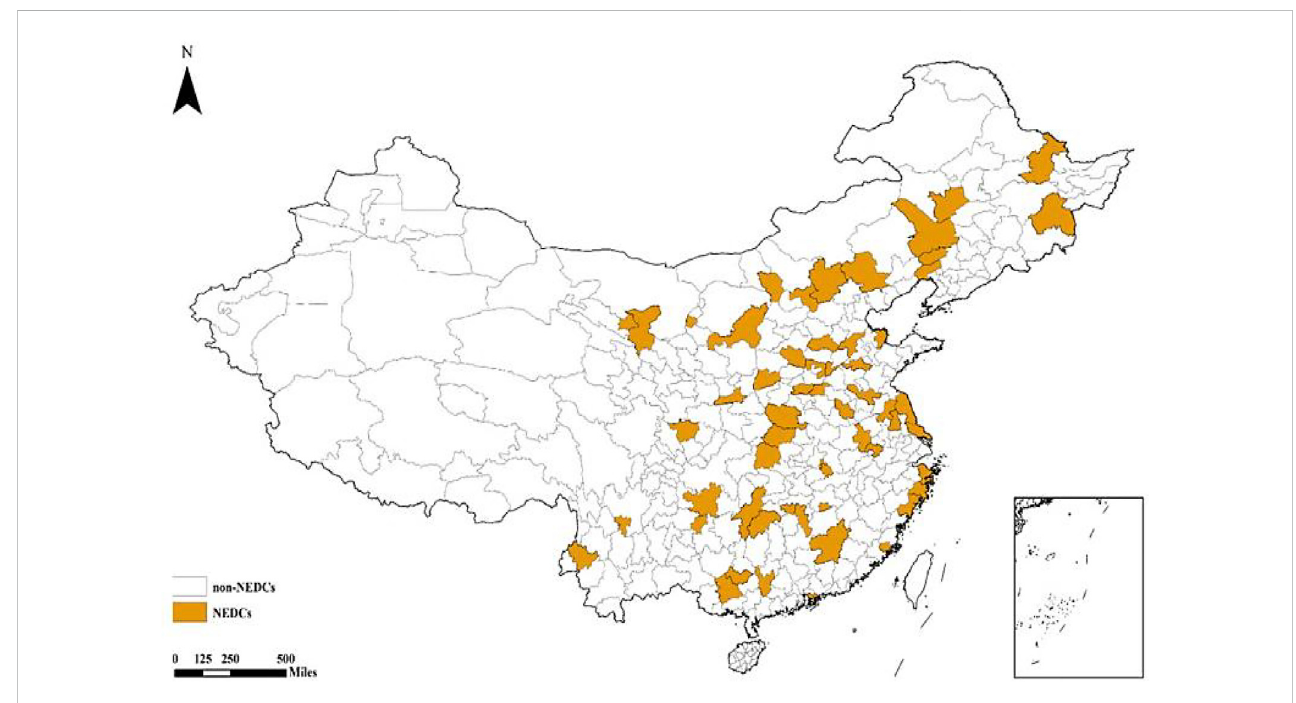
FIGURE 2 Spatial distribution of